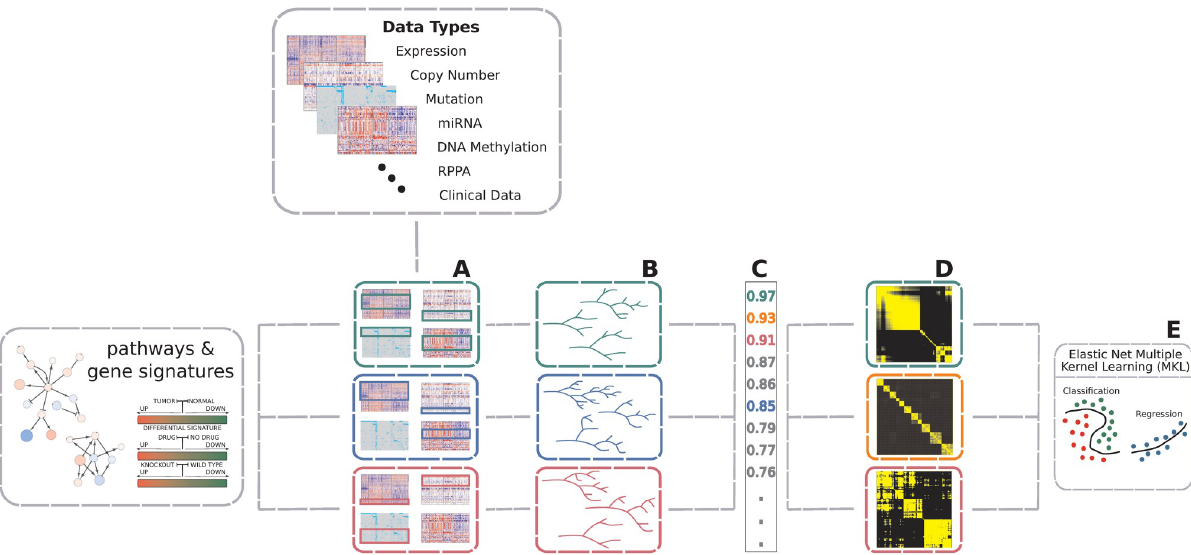
Fig 4. Overview of AKLIMATE. AKLIMATE takes as inputs multiple data types and a collection of feature sets. (A) Each feature set is overlapped with the available data types to identify all features that map to it (some feature sets might not extract features from all data types). (B) A feature-set-specific Random Forest model is trained on the multi-modal data identified in A. (C) RF models are ranked based on their predictive performance (metrics for mock RF models in A have matching color). (D) The top ranked RF models are converted to RF kernels (mock kernels shown for RF models with top 3 performance scores). (E) An elastic net MKL meta-learner finds the optimal combination of RF kernels and computes the final predictions. Elastic net hyperparameters are optimized via